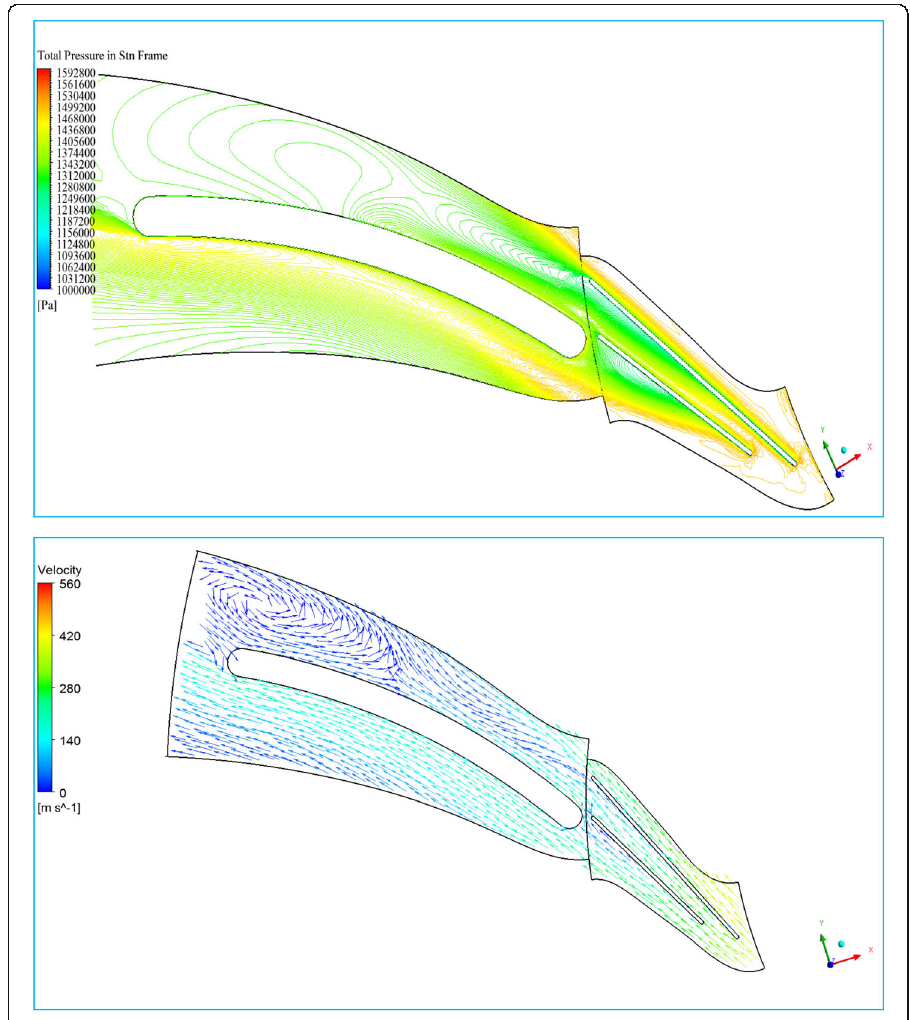
Fig. 12 Total pressure contours and velocity vectors at 50% span for configuration